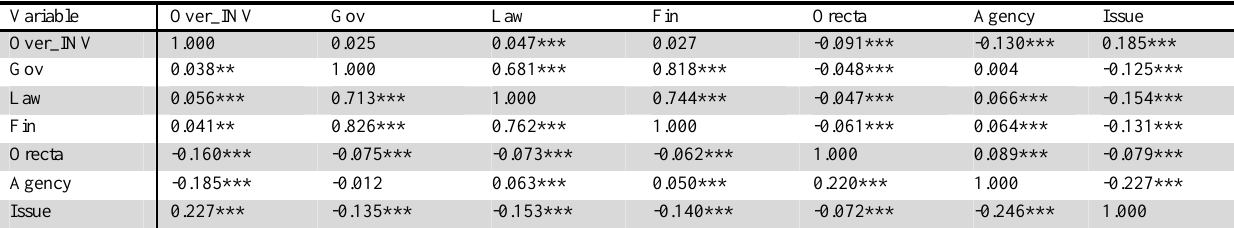
Correlation Values of Main